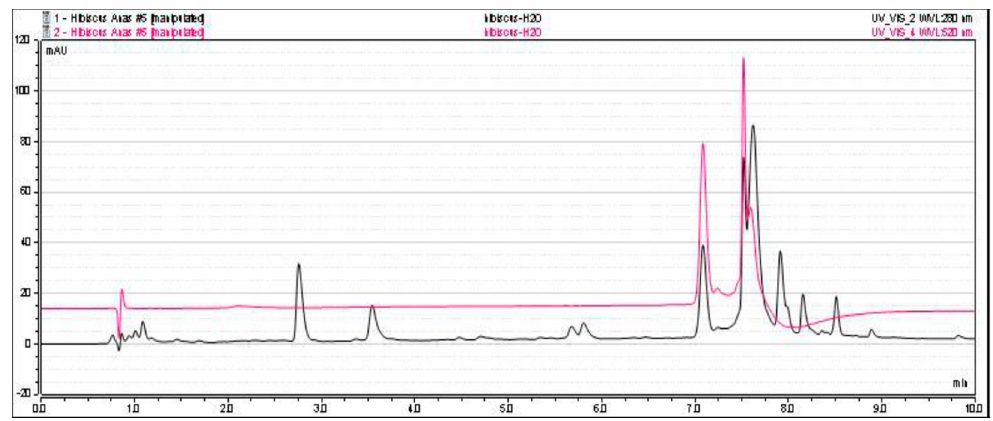
Figure 2. HPLC chromatogram from H. sabdariffa (HS) aqueous fraction (AF), recorded at 280 nm (black) and 520 nm (red).